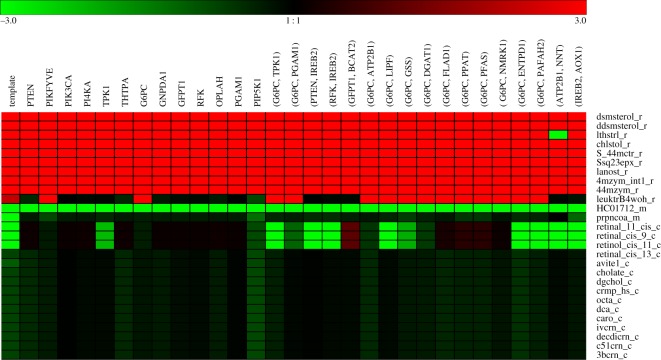
Hierarchical clustering of logarithmic fold changes in the choke-point metabolites. Hierarchical clustering of logarithmic fold changes, log2 (rdeficient/rnormal), in the choke-point metabolites in lipid metabolism for the template and all one-hit and two-hit deficiencies. Red colour indicates an increase, and green indicates a decrease.